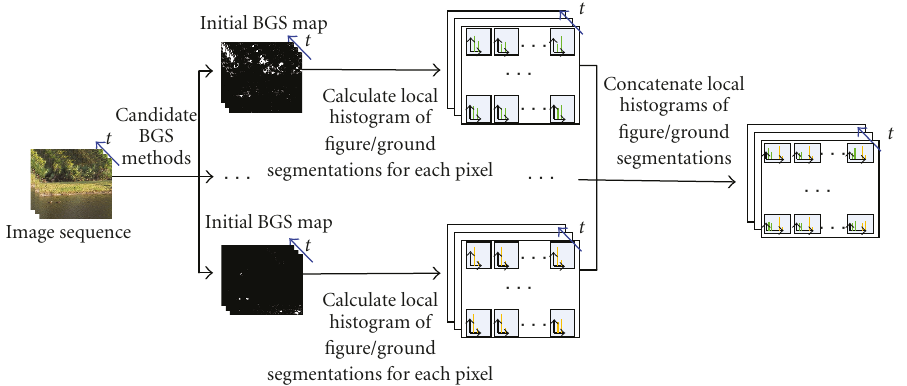
Figure 1: The process of constructing local histogram of figure/ground segmentations to form a final representation for each pixel. In the figure, t denotes a frame